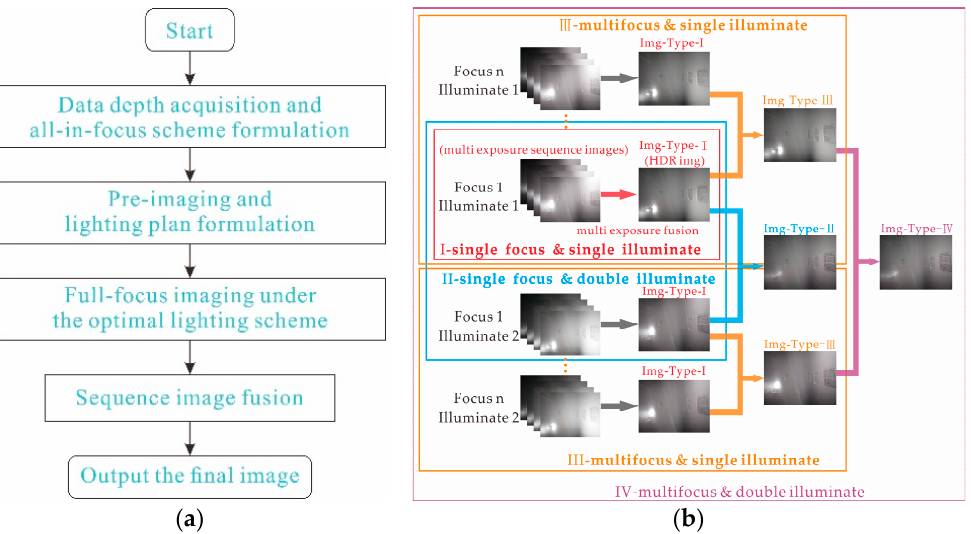
Figure 4. Imaging and fusion process: ( a ) the process of image acquisition by the imaging method in this paper; ( b ) the method and process of image fusion in this paper. I, the process in the red box indicates that the sequence images obtained under the imaging combination I in step 3 are subjected to multi-exposure fusion to obtain the Img-Type-1; the processes in the blue box and the orange box in II and III respectively indicate that, under imaging combinations II and III, by using wavelet fusion or multifocus fusion, the images of Img-Type-2 or Img-Type-3 can be obtained; the process shown in the purple box IV shows that image of Img-Type-4 can be obtained by fusing two images of Img-Type-3 under combination IV by multifocus fusion.